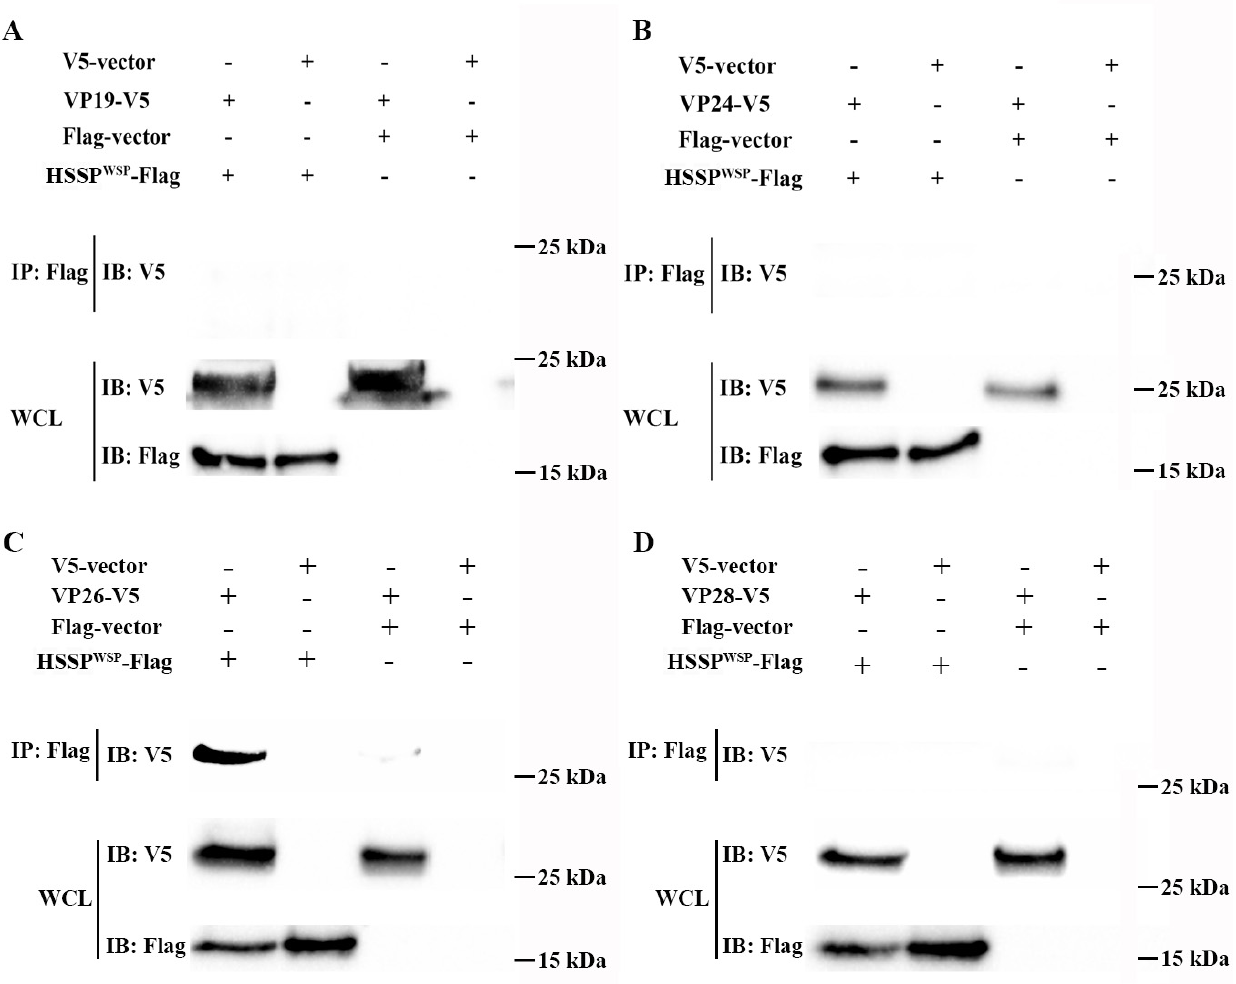
Figure 7. Interaction between LvHSSP and WSSV envelope protein. ( A ) Determination of the interaction between LvHSSP and VP19 by a Co-IP assay. Co-IP results showed that LvHSSP cannot interact with VP19. ( B ) Determination of the interaction between LvHSSP and VP24 by a Co-IP assay. Co-IP results showed that LvHSSP cannot interact with VP24. ( C ) Determination of the interaction between LvHSSP and VP26 by a Co-IP assay. Co-IP results showed that LvHSSP directly interacts with VP26. ( D ) Determination of the interaction between LvHSSP and VP28 by a Co-IP assay. Co-IP results showed that LvHSSP cannot interact with VP28. Anti-V5 Western blot bands show the expression of VP19-V5, VP24-V5, VP26-V5, or VP28-V5, and anti-Flag Western blot bands show the expression of LvHSSP-Flag.